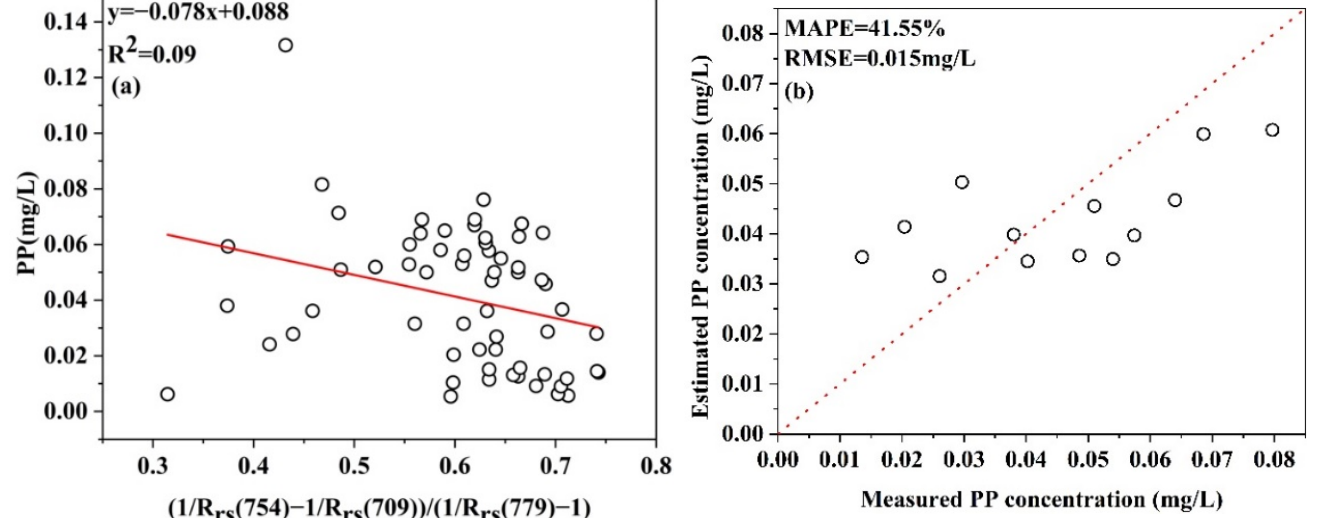
Figure 9. ( a ) The PP and R rs fitting curve; ( b ) comparison of the measured and estimated PP val-